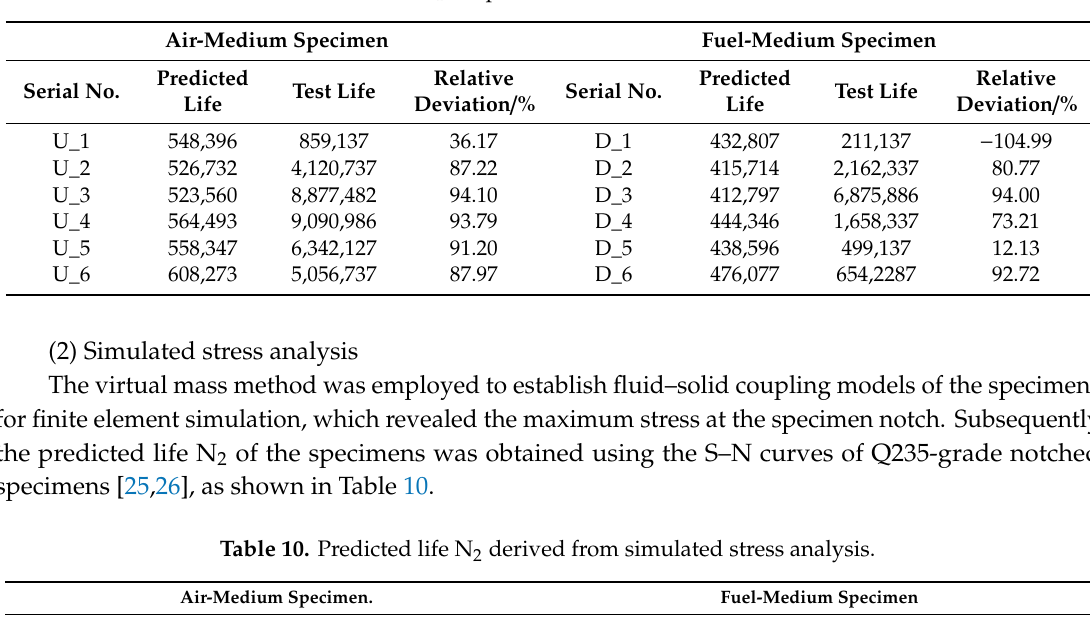
Table 9. Predicted life N 1 of specimens under narrowband distribution.